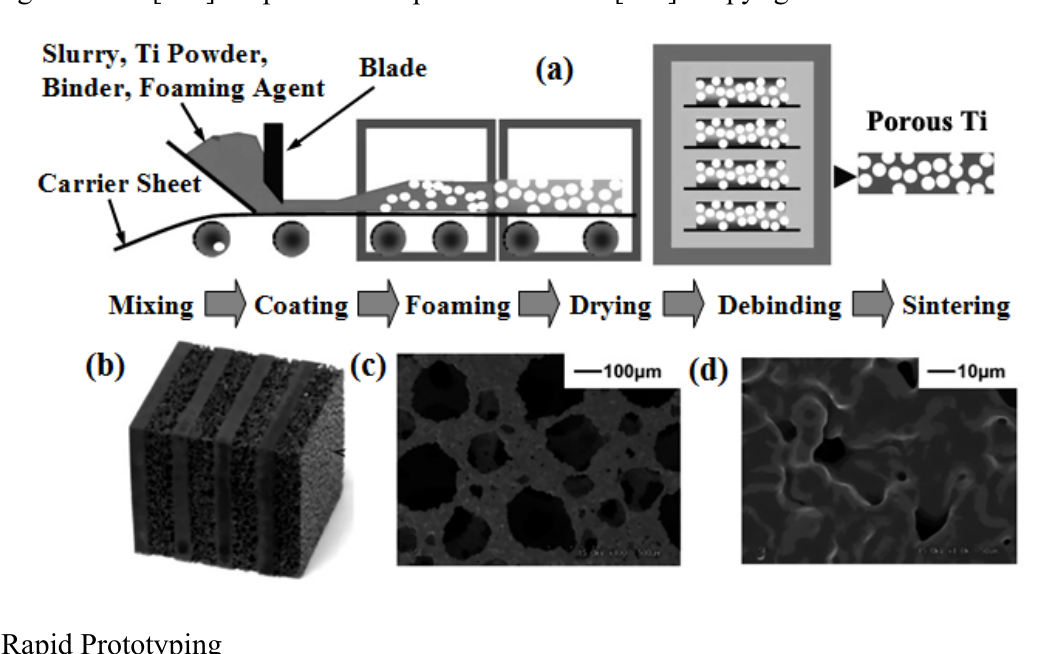
Figure 36. ( a ) Illustration of the slurry foaming method; ( b ) photograph of a multilayer porous titanium sample; ( c , d ) SEM microstructures of the arrow surface of ( b ) in ( c ) low and ( d ) high magnification [322]. Reprinted with permission from [322]. Copyright 2013